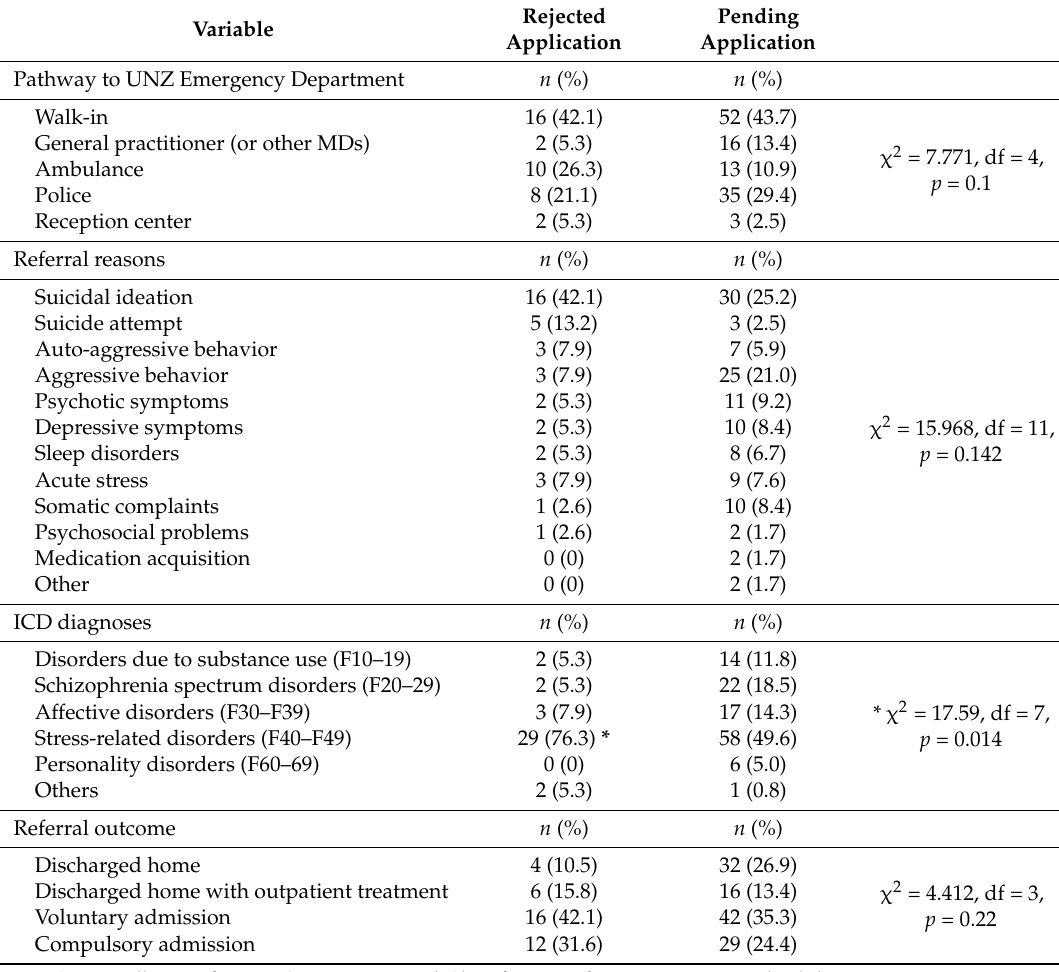
Table 3. The clinical characteristics of rejected ( n = 38) and pending applications ( n =